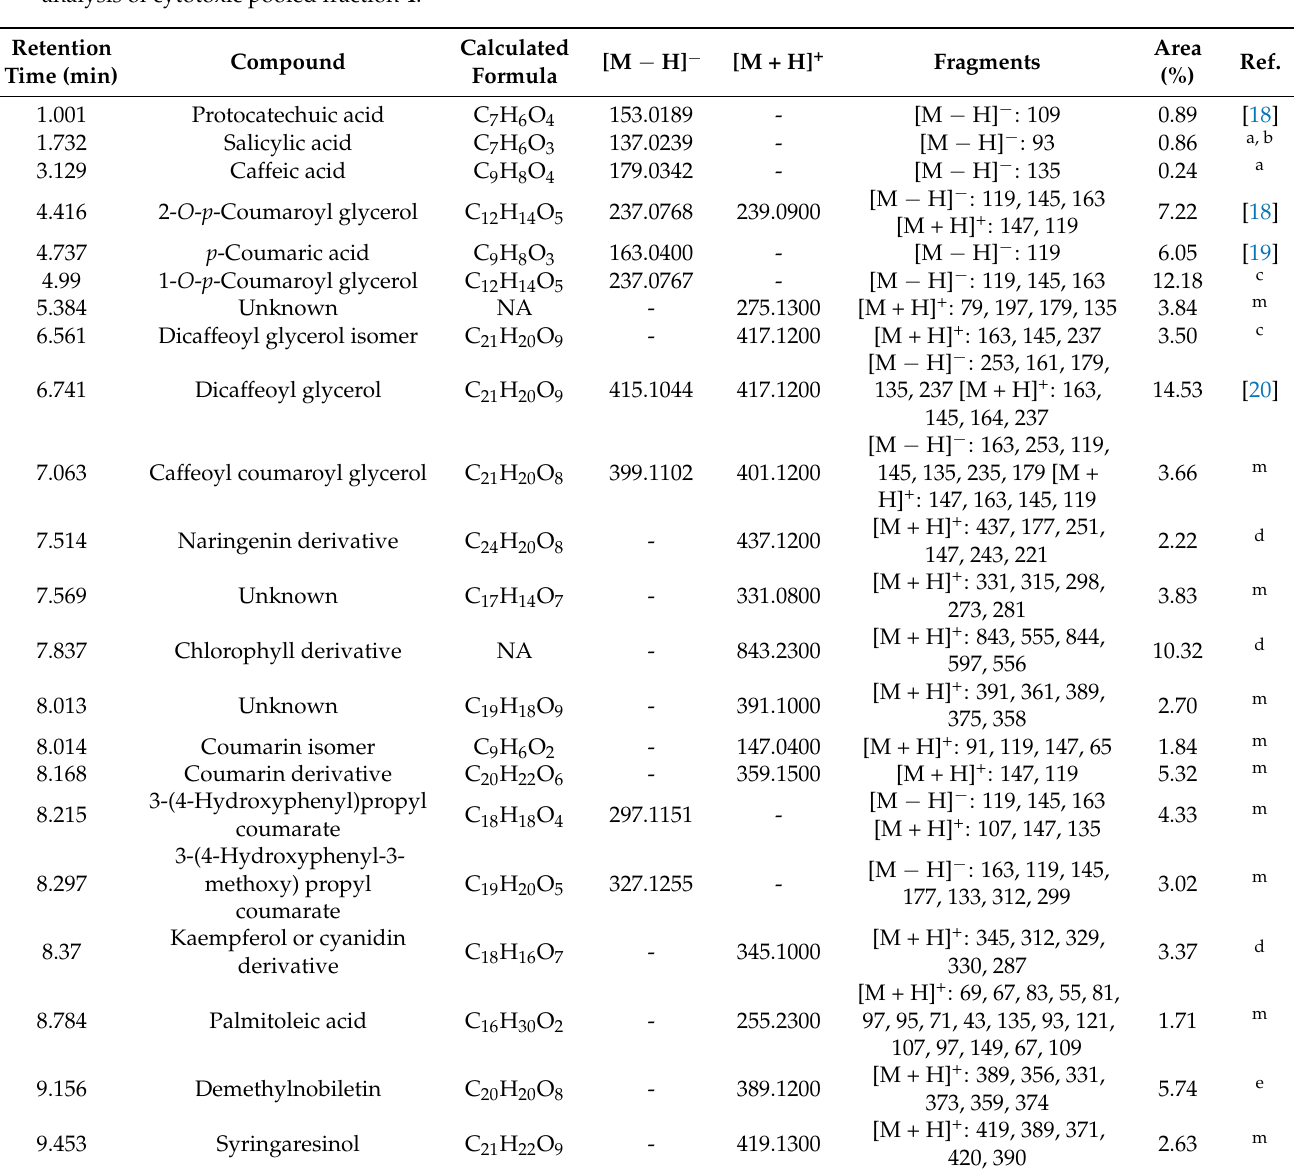
Table 3. High-performance liquid chromatography-quadrupole/time-of-flight-mass spectrometry (HPLC-QTOF-MS) analysis of cytotoxic pooled fraction 4